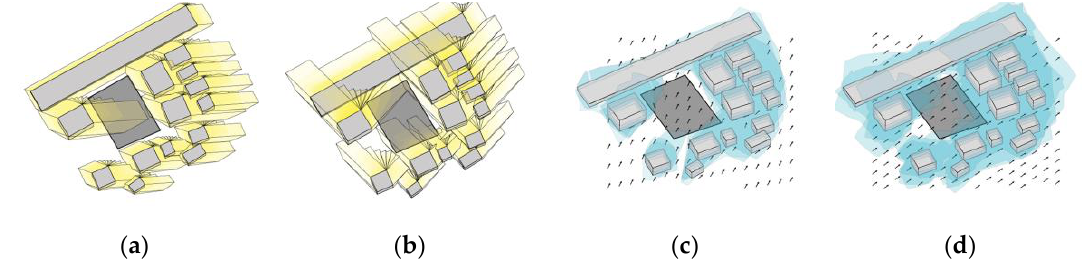
Figure 1. View atmospheric forts: ( a ) Shadows in summer time scenario; ( b ) Shadows in winter time scenario; ( c ) Wind field in summer time scenario; ( d ) Wind field in winter time